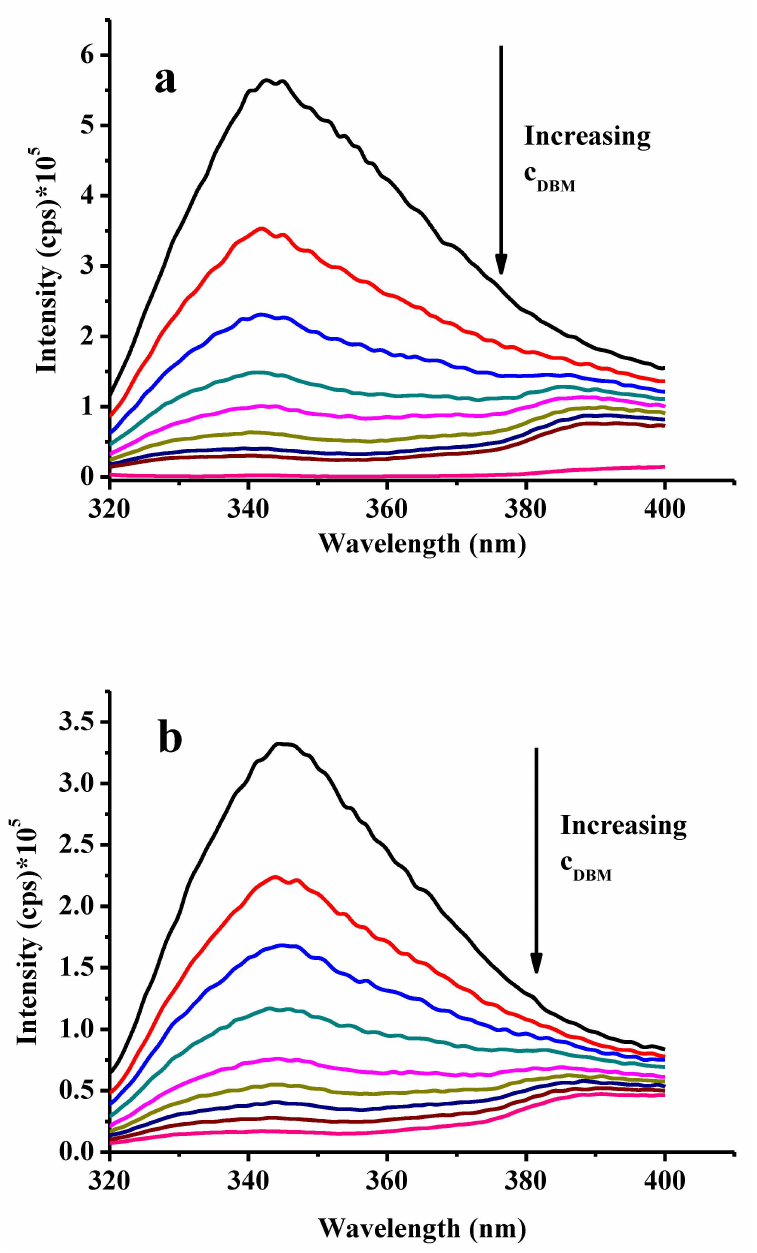
Figure 5. Fluorimetric curves of 10 µ M calixarene upon addition of increasing amounts of DBM in DMSO ( a ) and in 50–50 v / v % DMSO–water mixtures ( b